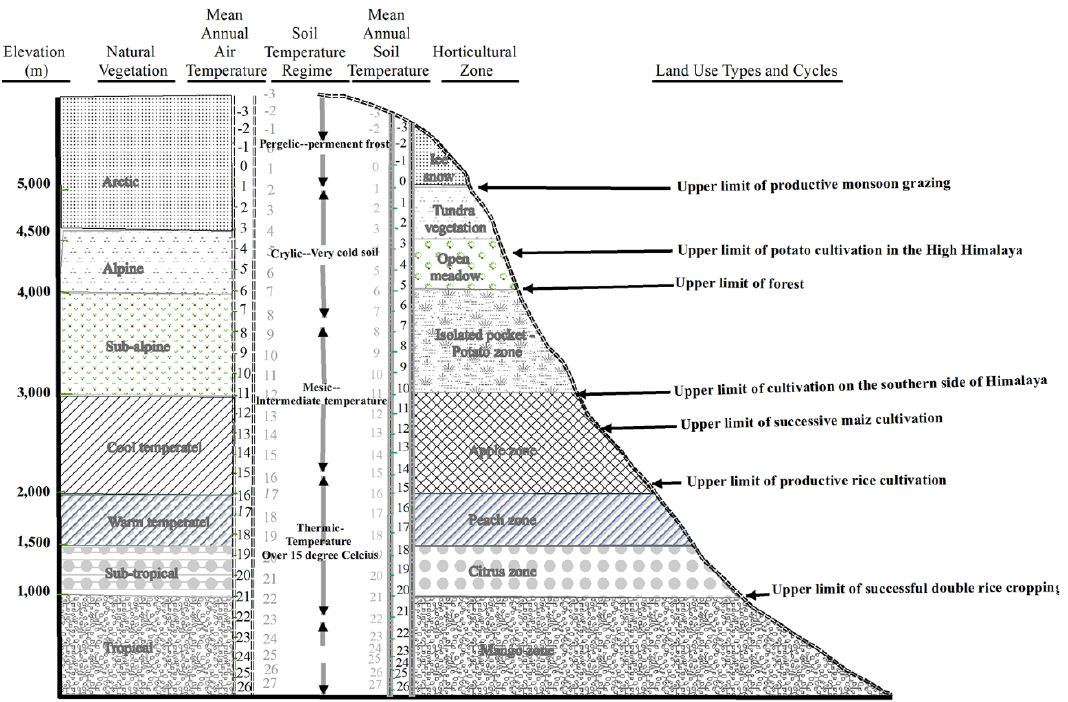
Figure 3. Agro-climatic zones of Nepal (adapted and modified from [16,37]).